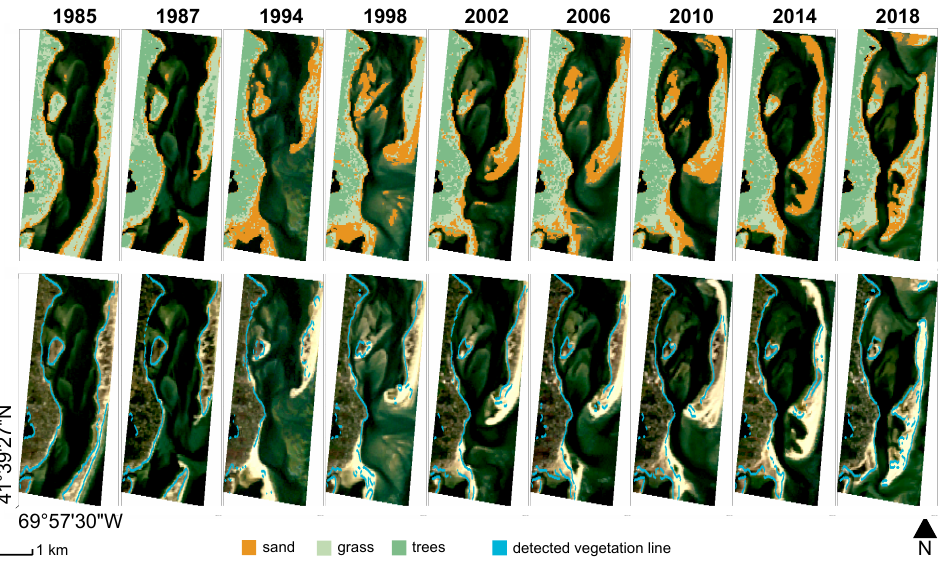
Figure 8. Time evolution of the coastal barrier protecting the city of Chatham (Massachusetts, USA). The classified images in the upper row of panels show the land cover changes and highlight the geomorphological evolution of the area, whereas the cyan lines in the lower row of panels show the evolution of the vegetation–sand interface (EPSG: